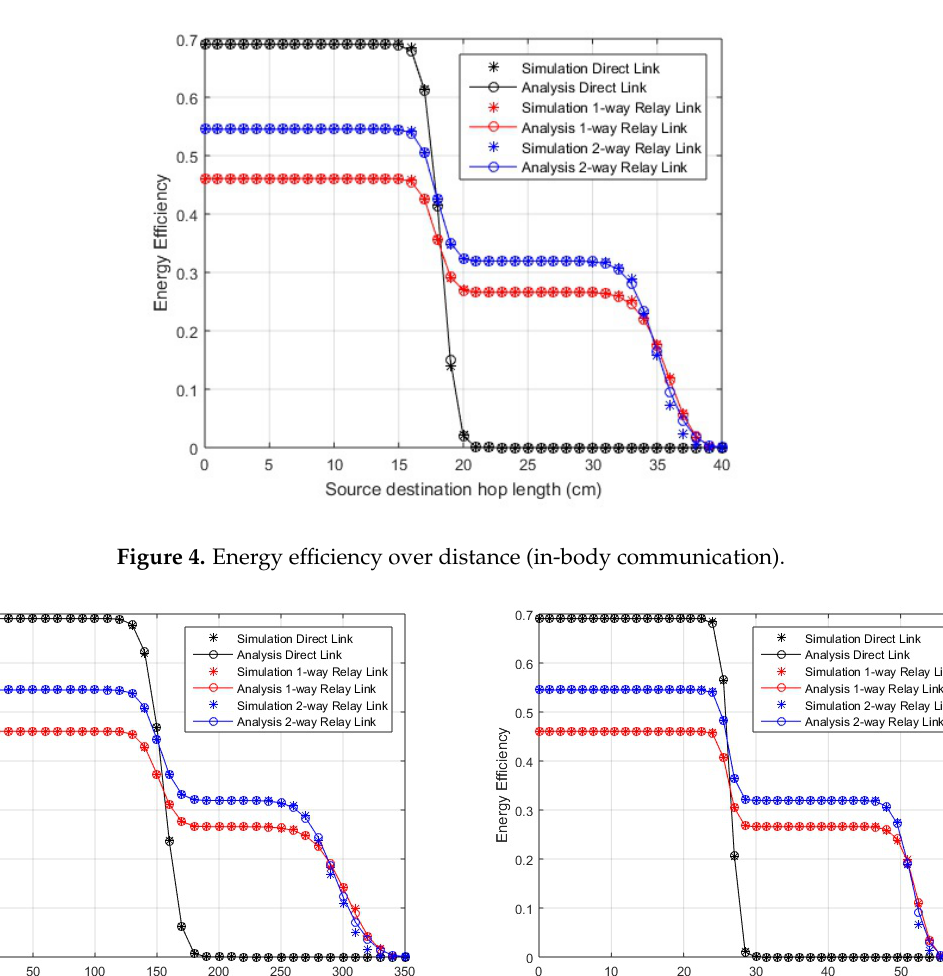
Figure 5. Energy efficiency over distance (on-body communication). ( a ) energy efficiency over distance (on-body LOS communication); ( b ) energy efficiency over distance (on-body NLOS